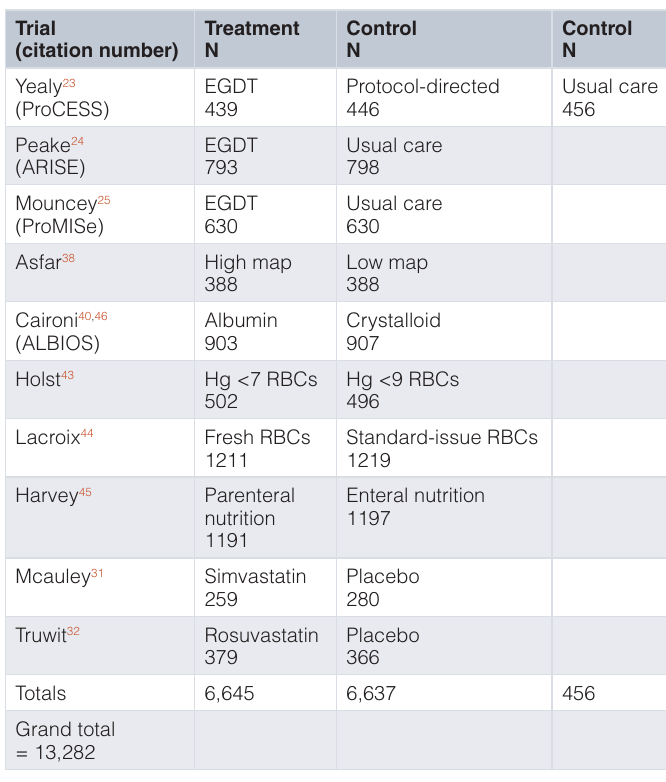
Table 1. Sample sizes of large multicenter pivotal RCTs relevant to severe sepsis, septic shock and acute respiratory distress syndrome (ARDS) published in 2014 and early